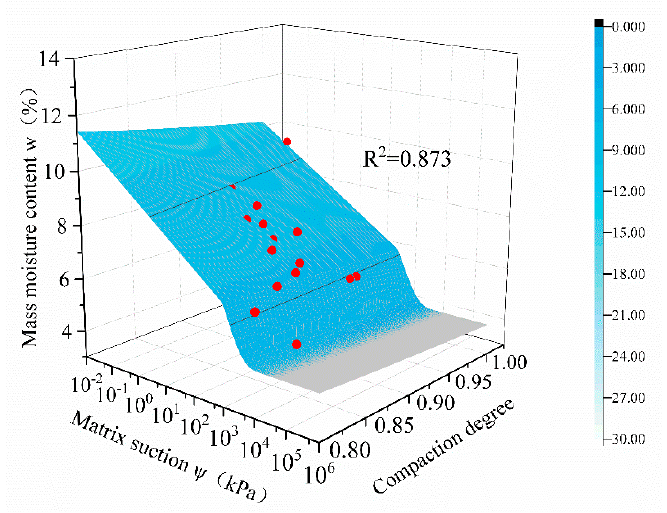
Figure 4. Soil–water characteristic